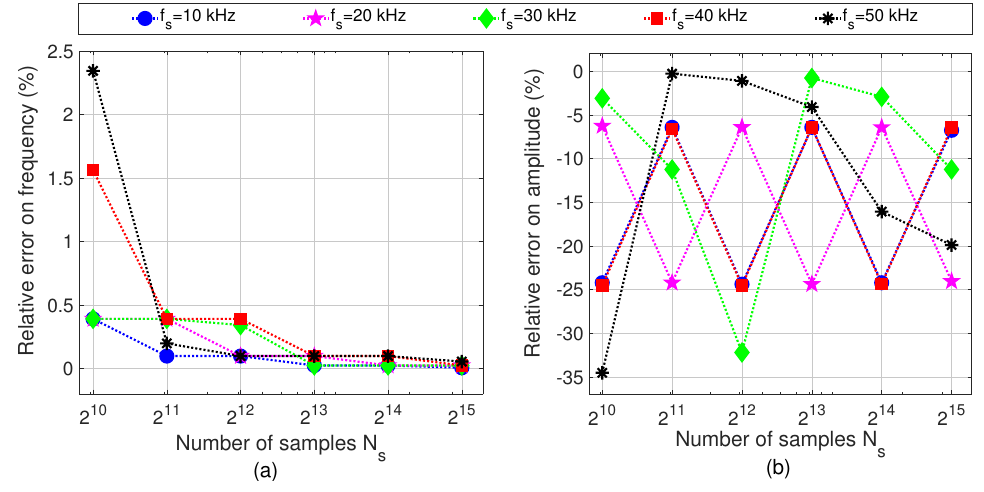
Figure 5. Relative error affecting the ( a ) fundamental frequency and ( b ) amplitude of the input sinusoidal signal, when no windowing is used.